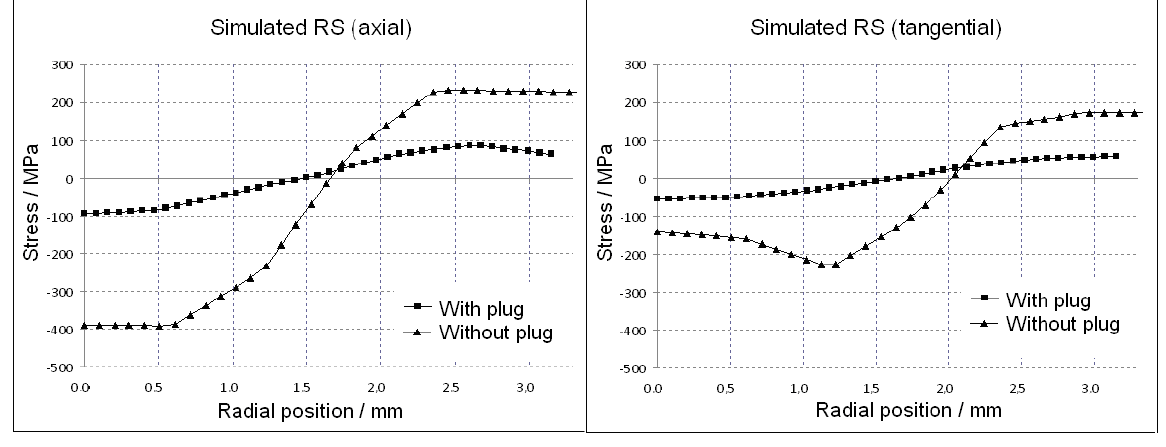
Figure 8. Simulated residual stresses (RS) for drawn tubes (with and without a plug), ( a ) in axial and ( b ) in tangential